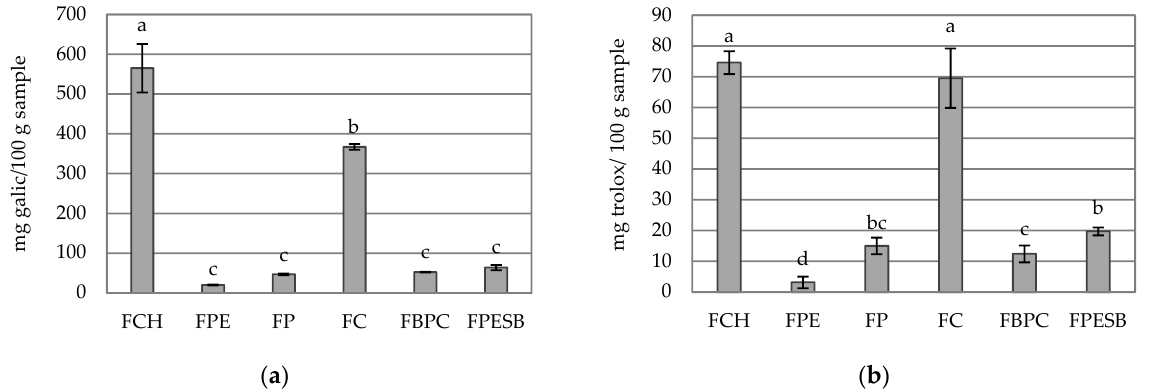
Figure 4. Mean values and standard deviations of ( a ) the samples’ total phenol content and ( b ) antioxidant capacity. Letters indicate the homogeneous groups established by the ANOVA ( p < 0.05).